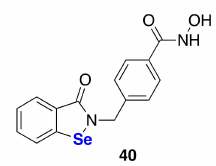
Figure 10. Structure of HDAC6